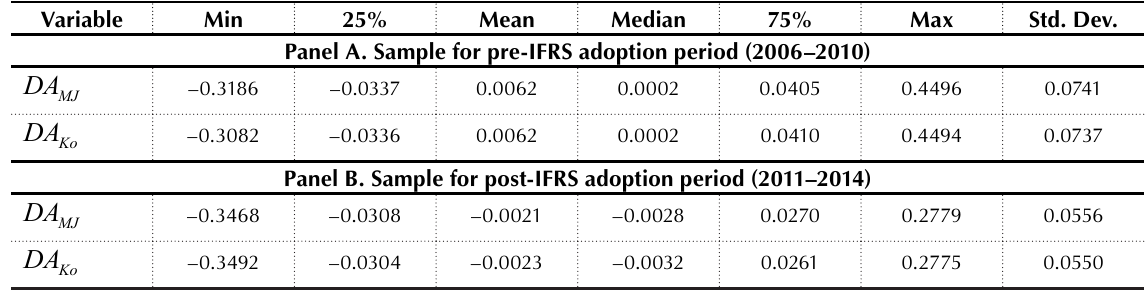
Table 4. Descriptive statistics: accruals